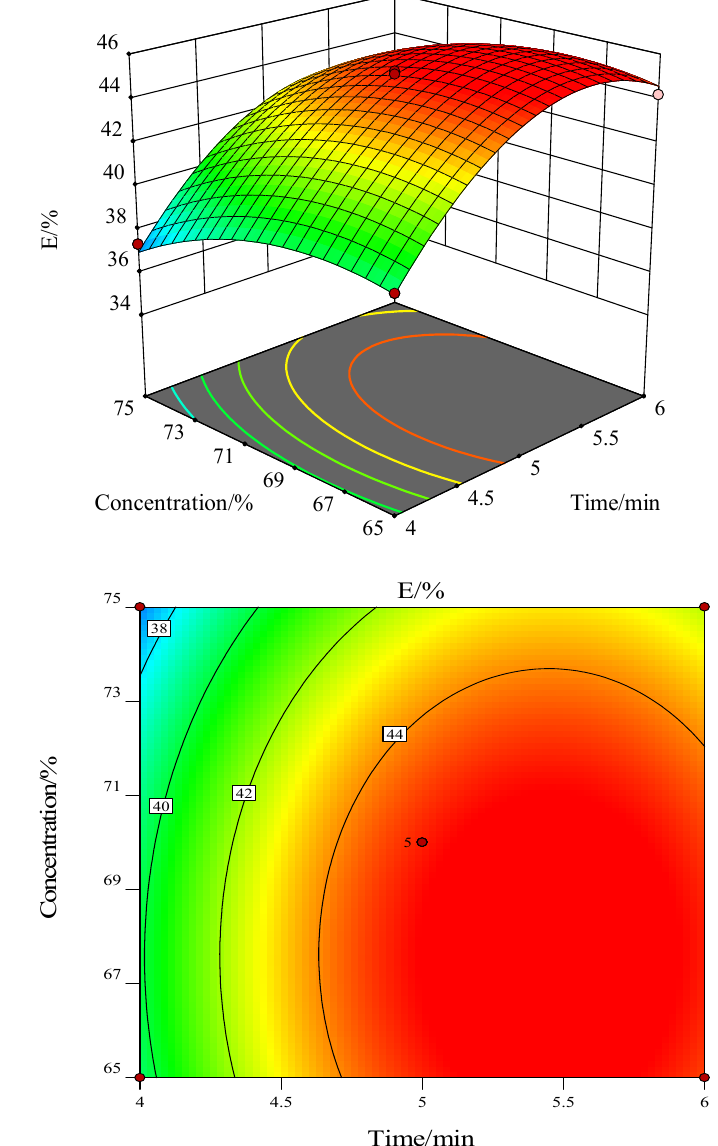
Figure 9. Response surface diagram and contour map at the action of grinding time and grinding concentration.